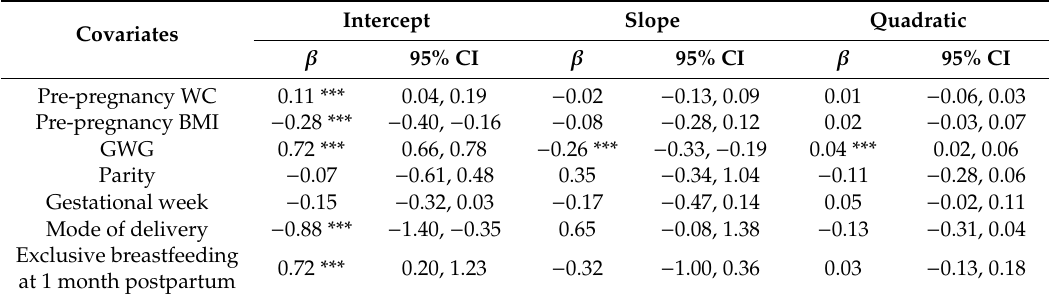
Table 5. Estimates of covariate prediction of intercept and slopes of the trajectory for PPWR.